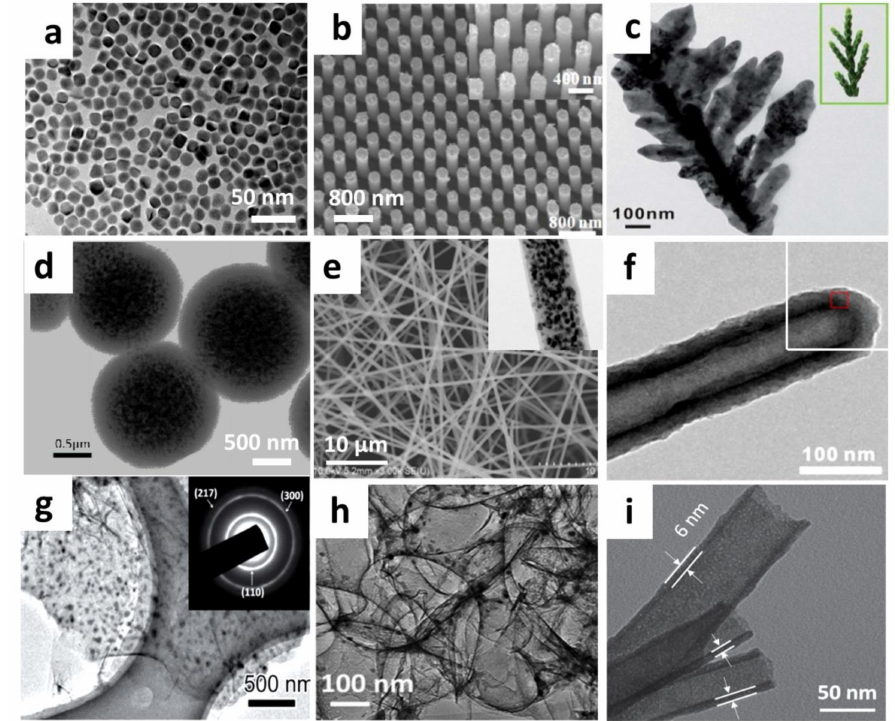
Figure 2. Representative morphologies (SEM or TEM images) of several Sb-based hybrid nanostruc- tured electrodes: ( a ) monodispersive Sb nanocrystals; ( b ) ordered Sb nanorods array; ( c ) cypress-leaf like Sb; ( d ) Spherical nano-Sb@C composite; ( e ) Electrospun Sb/C Fibers; ( f ) Sb@C coaxial nanotubes; ( g ) Sb/rGO paper-like anode; ( h ) antimony nanoparticles anchored in three-dimensional carbon network; ( i ) double-walled crystalline Sb@amorphous TiO 2 − x